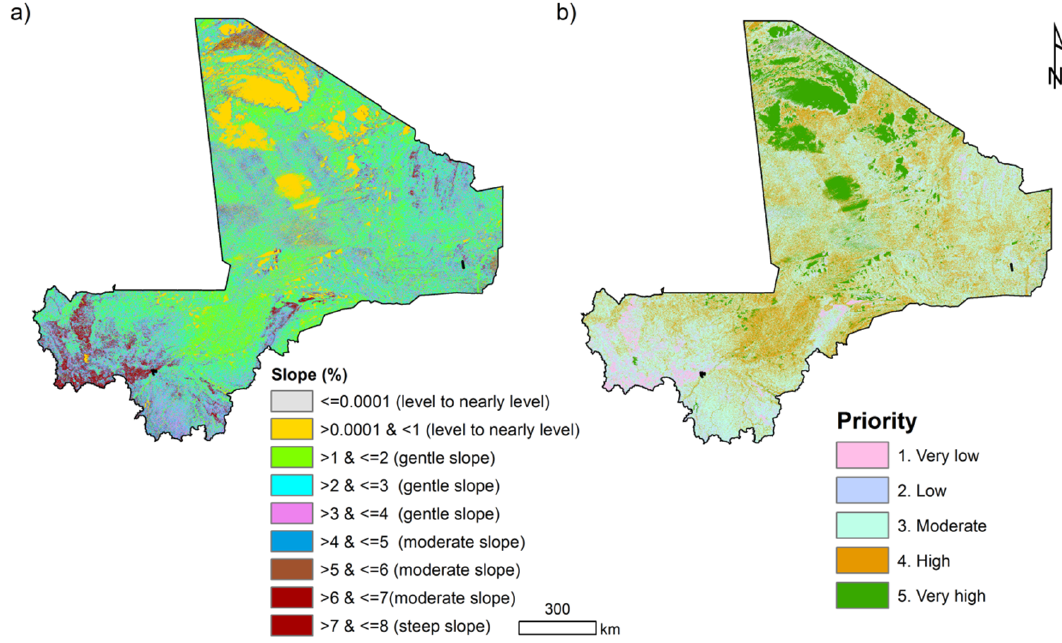
Figure 6. Slope map of Mali (extracted from SRTM DEM: http://srtm.sci.cgiar.org/): ( a ) slope class; and ( b ) priority category.